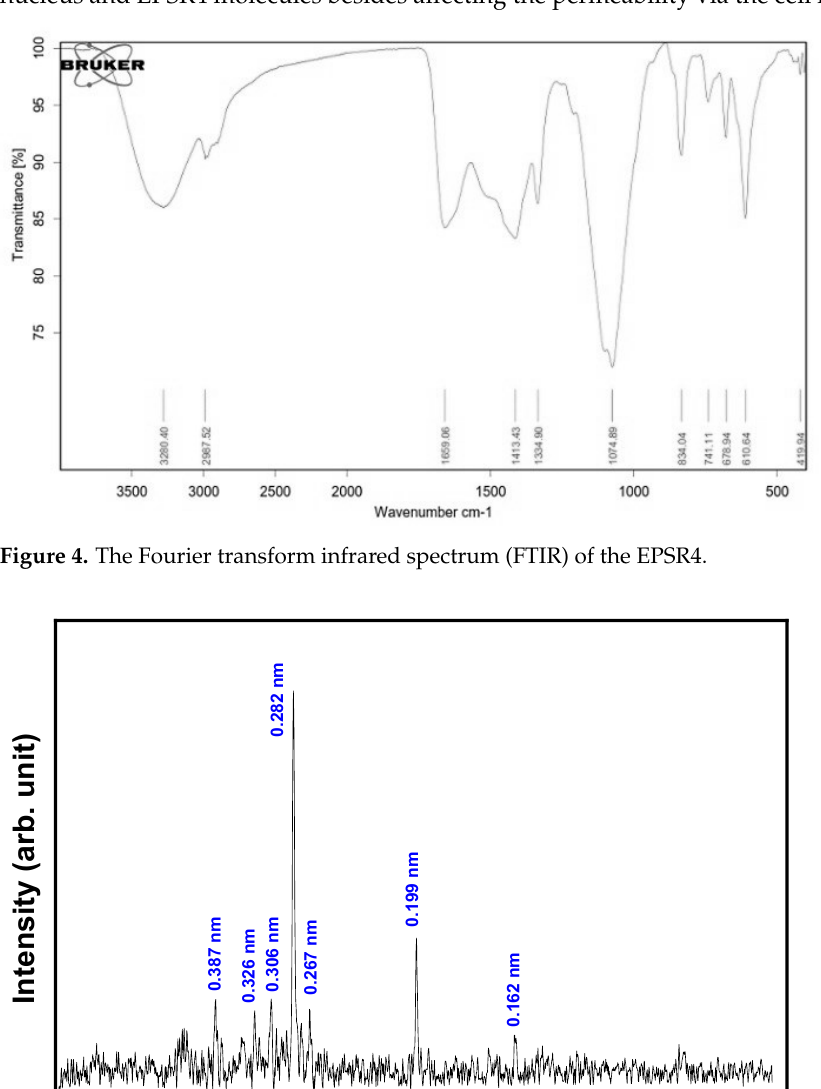
Figure 4. The Fourier transform infrared spectrum (FTIR) of the EPSR4.